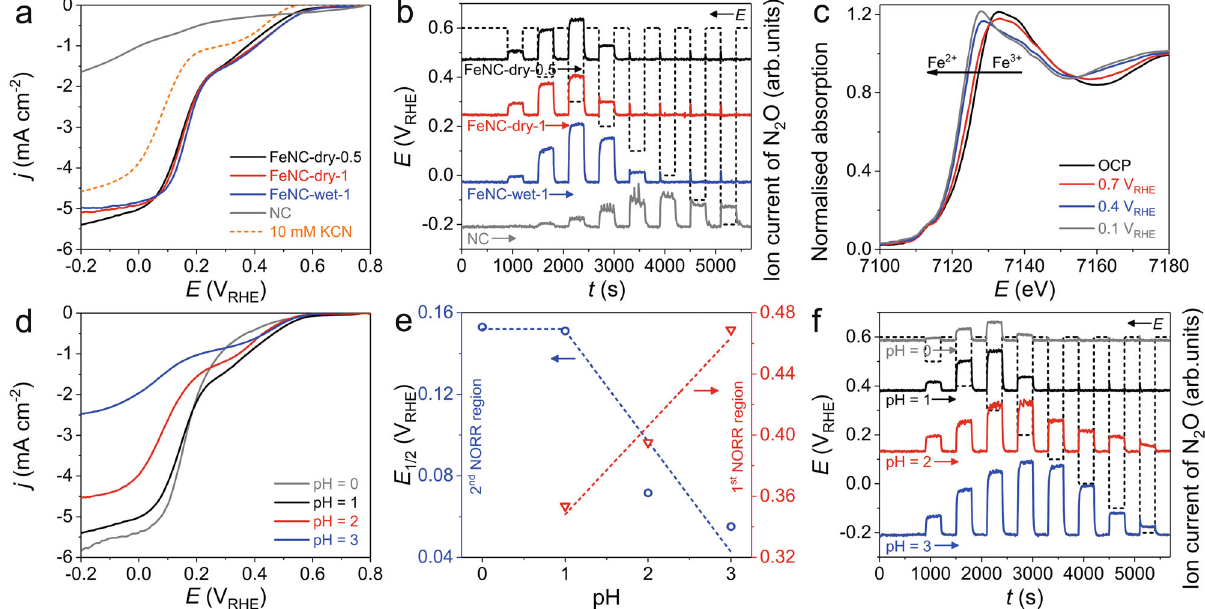
Fig. 2 Determination of catalytic active site and pH-dependency of NORR selectivity. a NORR polarisation curves of FeNC-dry-0.5, FeNC-dry-1, FeNC- wet-1, and NC measured in a NO-saturated 0.1 M HClO 4 electrolyte. Poisoning of FeNC-dry-0.5 was also examined with 10 mM KCN. b N 2 O formation detected by online SFC/DEMS. c In situ XANES results of FeNC-dry-0.5 polarised at 0.1, 0.4, 0.7 V RHE , and OCP (see details in Supplementary Fig. 11). d NORR polarisation curves of FeNC-dry-0.5 measured at various electrolyte pH 0 – 3. e Correlations of the electrolyte pH with E 1/2 estimated at the 1st and 2nd NORR regions. f Effects of electrolyte pH on N 2 O formation of FeNC-dry-0.5 measured by online